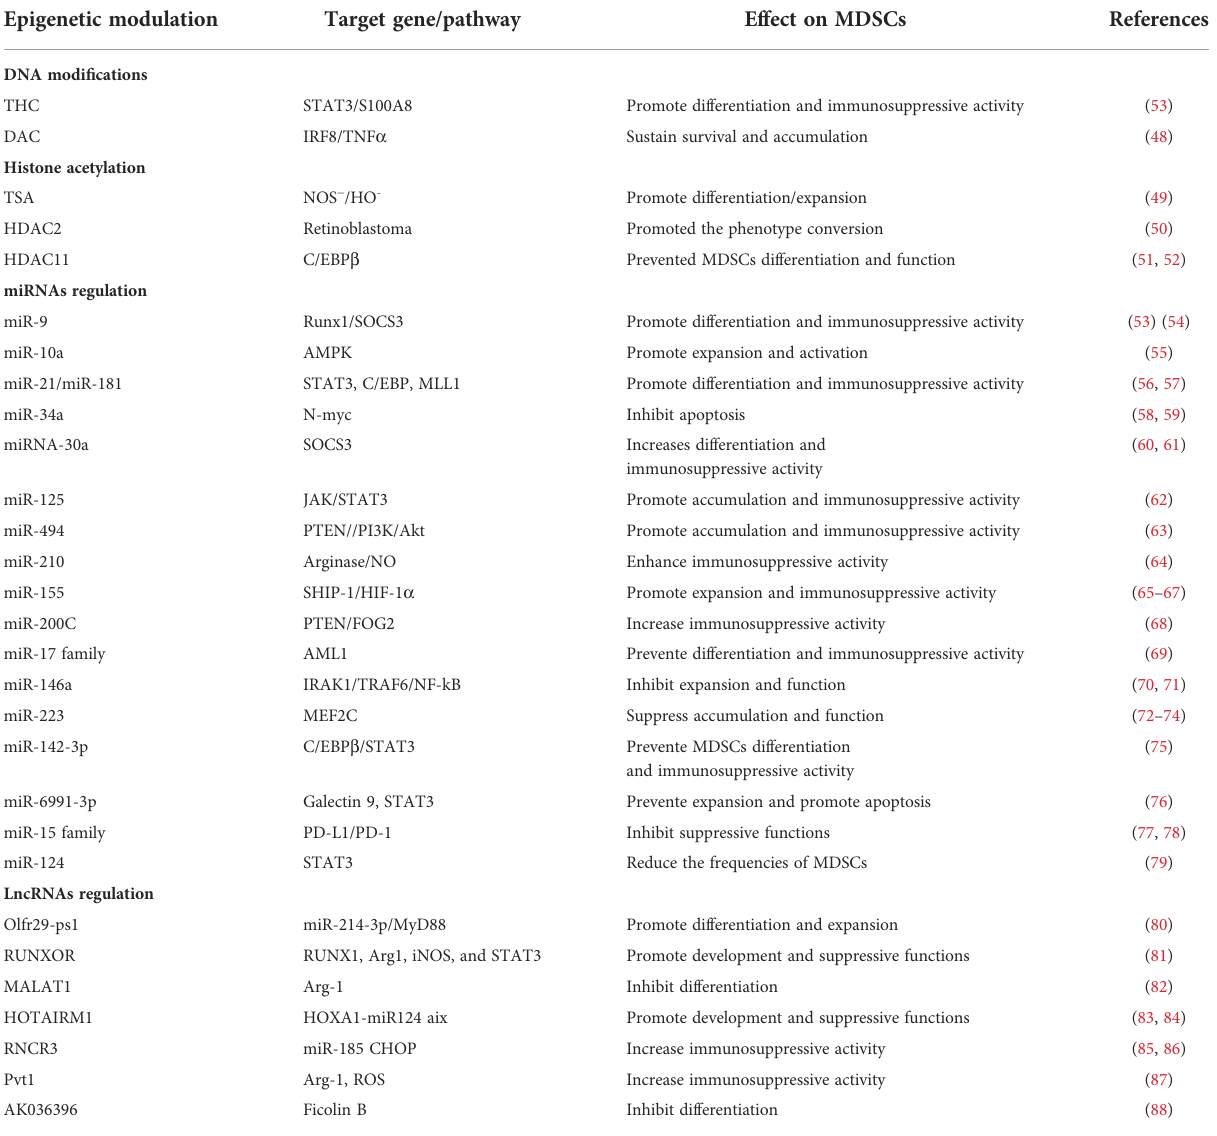
TABLE 2 The epigenetic regulation in the development and function of